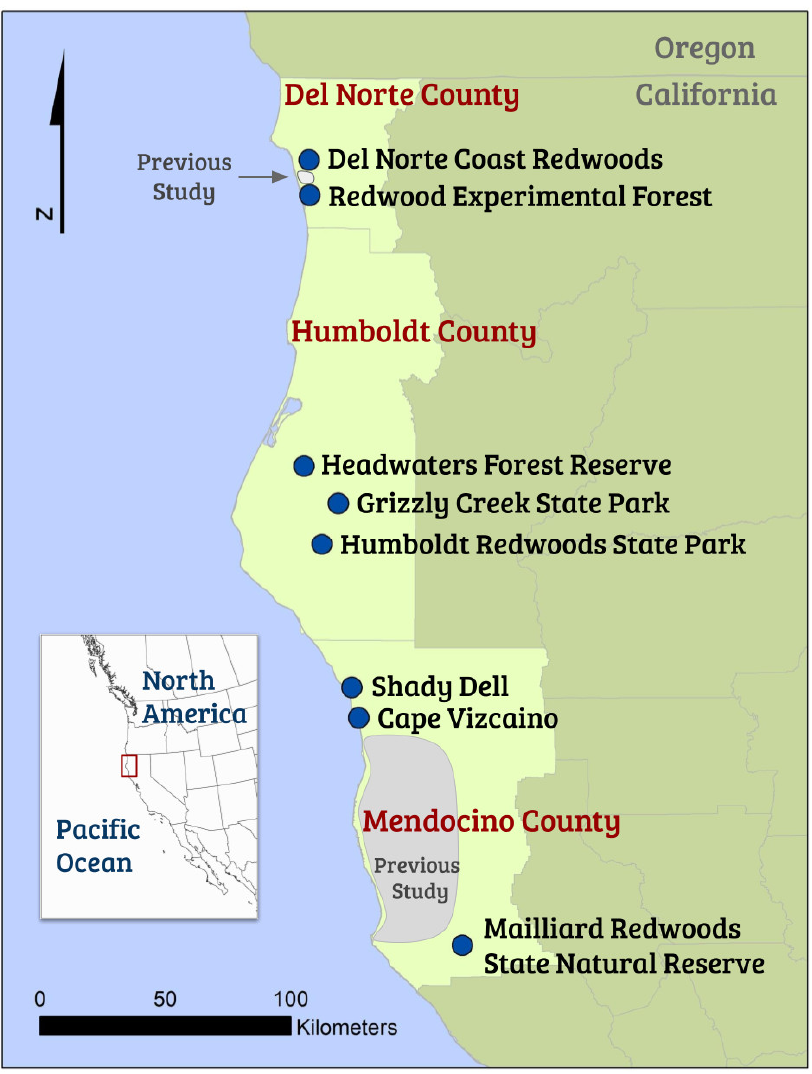
Figure 1. Basal hollow study sites on the North Coast of California (N-arrow denotes North; WGS 1984 UTM Zone 10 North; County boundary source: ESRI). Previous studies include Gellman and Zielinski [11], Zielinski and Gellman [12], Purdy [13], Zielinski, et al. [16], and Roberts [17]. At each site, we located tree hollows with initial guidance from the participating land managers. We searched forests of various ages within sites, but basal hollows were mainly found in old-growth forests, apart from a few retained “legacy” trees. From the initial hollows identified, we searched forests within a radius of at least 100 m from each new hollow to locate other hollows (see Supplementary Figure S1). Half of the searches were intentionally conducted off roads or trails to reduce anthropocentric bias. We recorded all hollow locations with a Global Positioning System (GPS) and mapped them with ArcMap 10.4.1 (ESRI, Redlands, CA; WGS 1984 Zone 10 North, Figure 1). We included basal hol- lows if they met the minimum threshold of having closed tops with ceilings above the cavity opening [11]. There was no minimum size of the hollow opening. Hollow dimen- sion measurements were based on field tests and established methods (Figure 2, Table 1) [11,16].